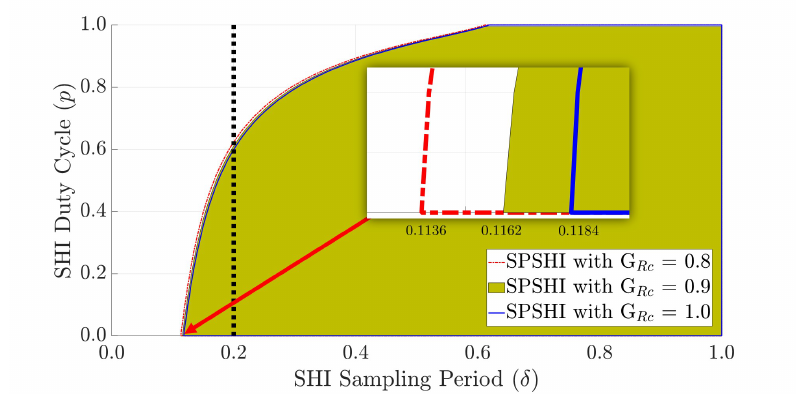
Figure 10. The feasible region of the closed-loop MS system with SPSHI.